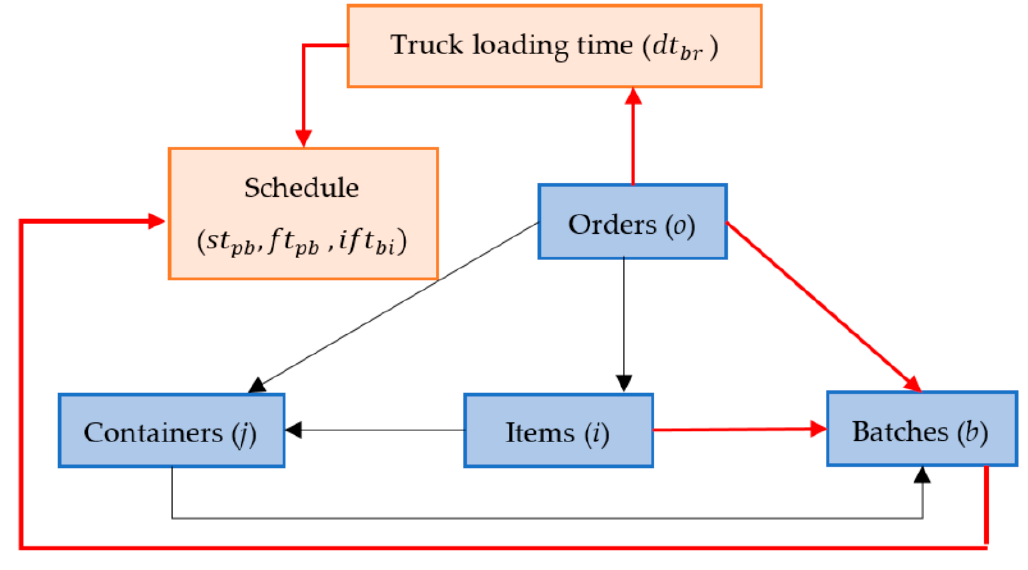
Figure 4. The relation of considered factors.